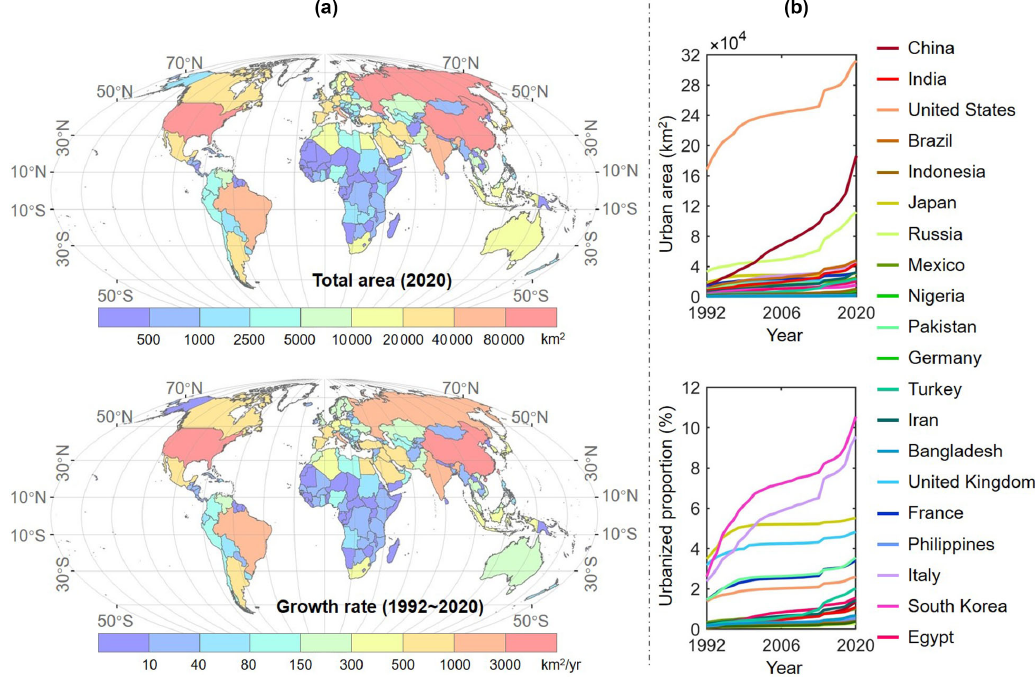
Figure 12. Dynamics of urban extents from 1992 to 2020 both at the country level (a) and in the top 20 countries ranked by urban population in 2018 (b) .